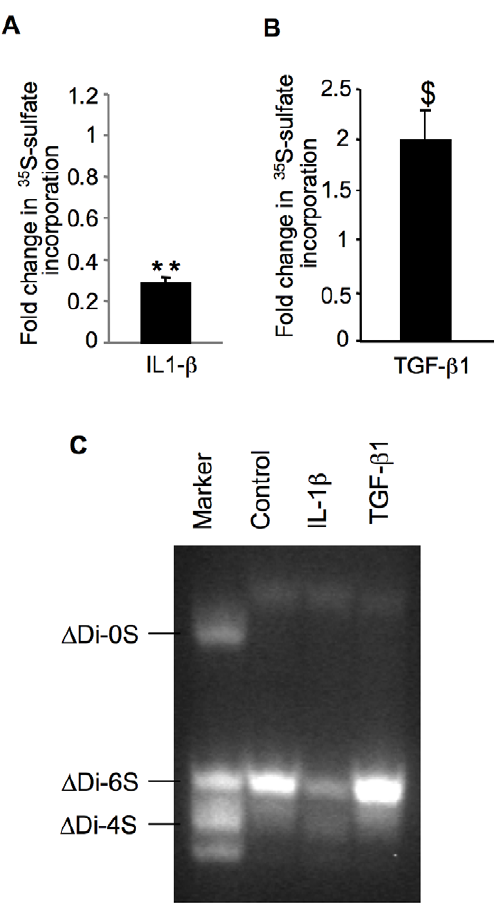
Figure 6. Analysis of the effect of IL-1 b and TGF- b 1 on GAG synthesis and GAG chain composition. Cartilage explants from normal regions of human femoral condyle were exposed to IL-1 b (A) or TGF- b 1 (B) for 24 h and then GAG synthesis was measured by 35 S- sulfate incorporation. Measurements were normalized to control (non treated). Data are mean 6 SD of 3 experiments per parameter, per joint, per patient. **Significantly ( P , 0.0018) lower than controls; $ significantly (P , 0.05) higher than controls. (C) Effect of IL-1 b and TGF- b 1 on GAG chain composition in human cartilage. Cartilage samples derived from normal regions of human femoral condyle were treated with cytokines for 12 h and analyzed by FACE. Gels are representative images from 3 experiments per parameter, per joint, per patient. Markers are D Di0S, nonsulfated chondroitin-unsaturated disaccharide; D Di4S, chondroitin- 4-sulfated unsaturated disaccharide; D Di6S, chondroitin-6-sulfated unsaturated disaccharide.